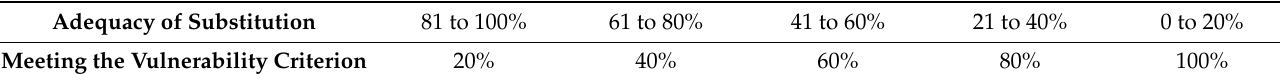
Table 4. Adequacy of the